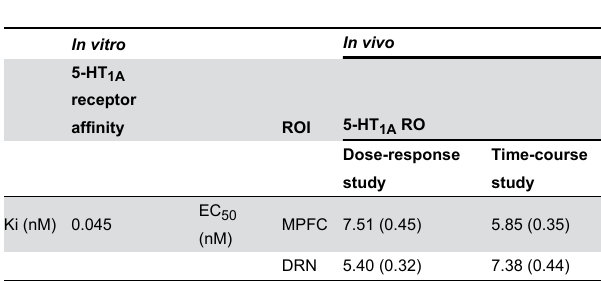
Table 1. In vitro pharmacological profile and in vivo PD parameter estimates for E2110.